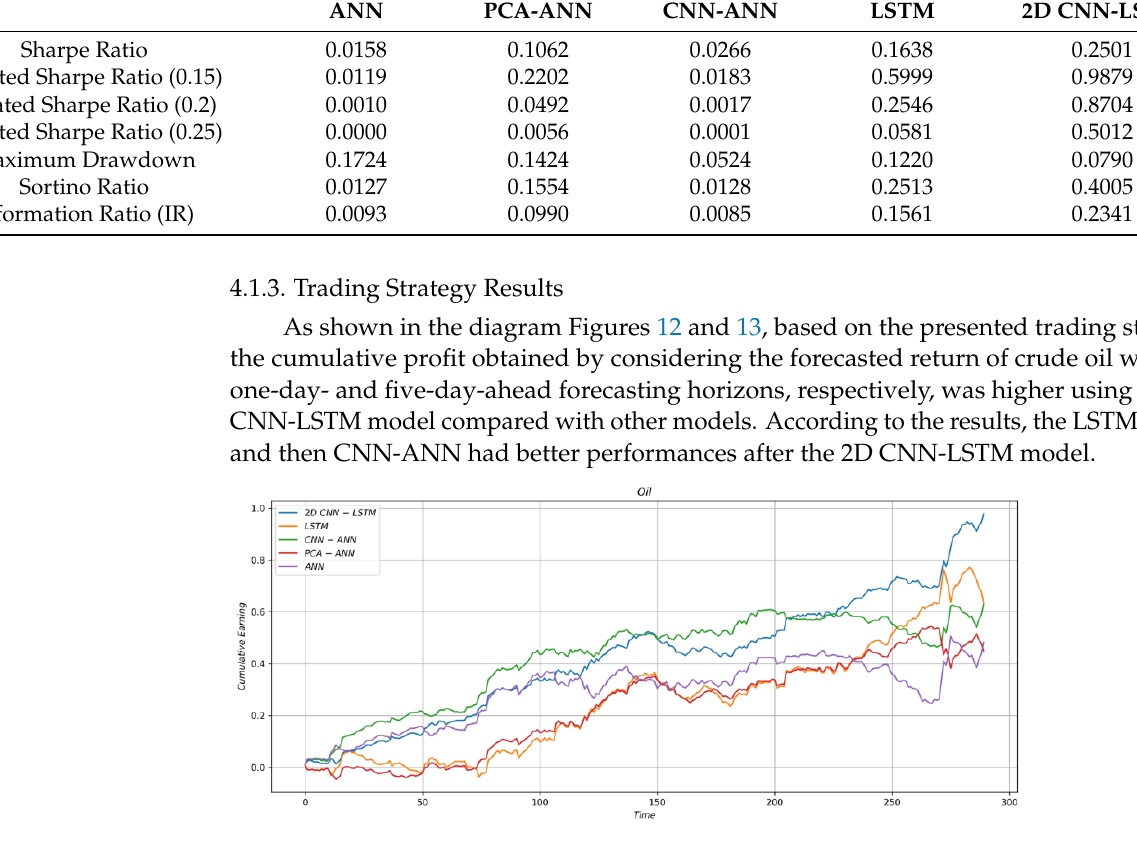
Table 13. The Amount of Each Measure with One-Day-Ahead Forecast.